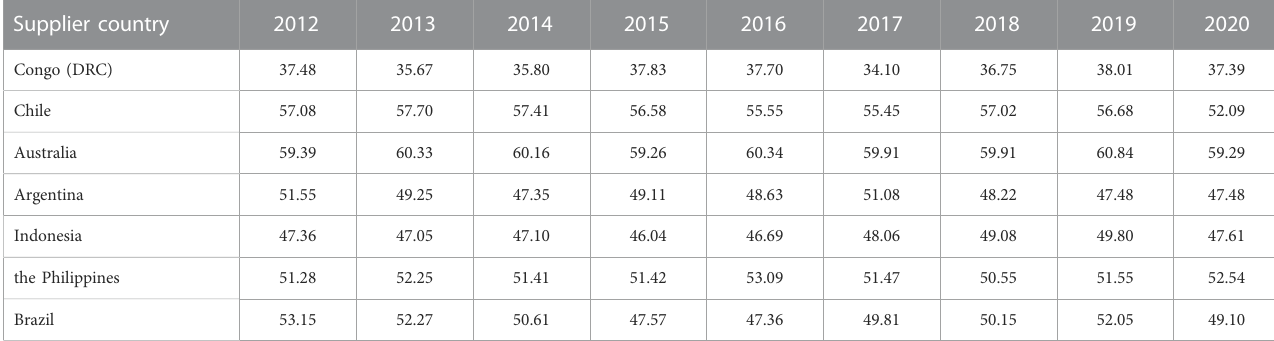
TABLE 4 Country Risk Index (ICR) for critical mineral supply countries. Supplier country